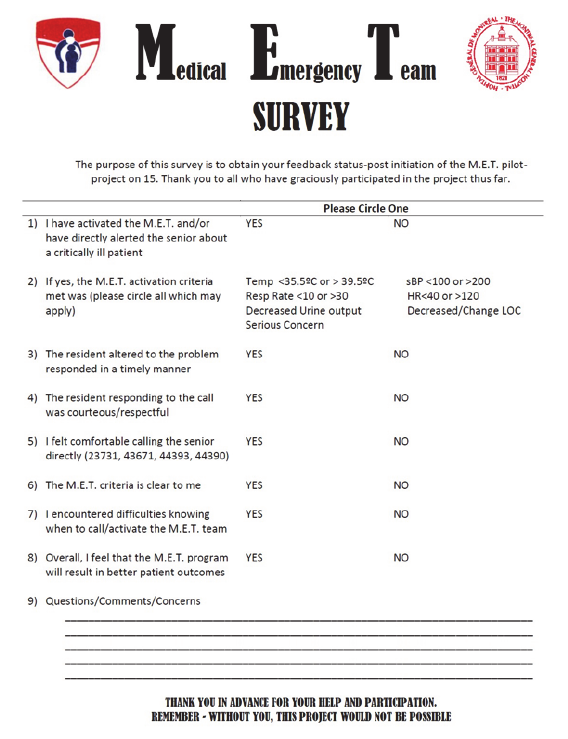
Figure 3: Sample poster: system activation criteria. Figure 4: Sample of nursing